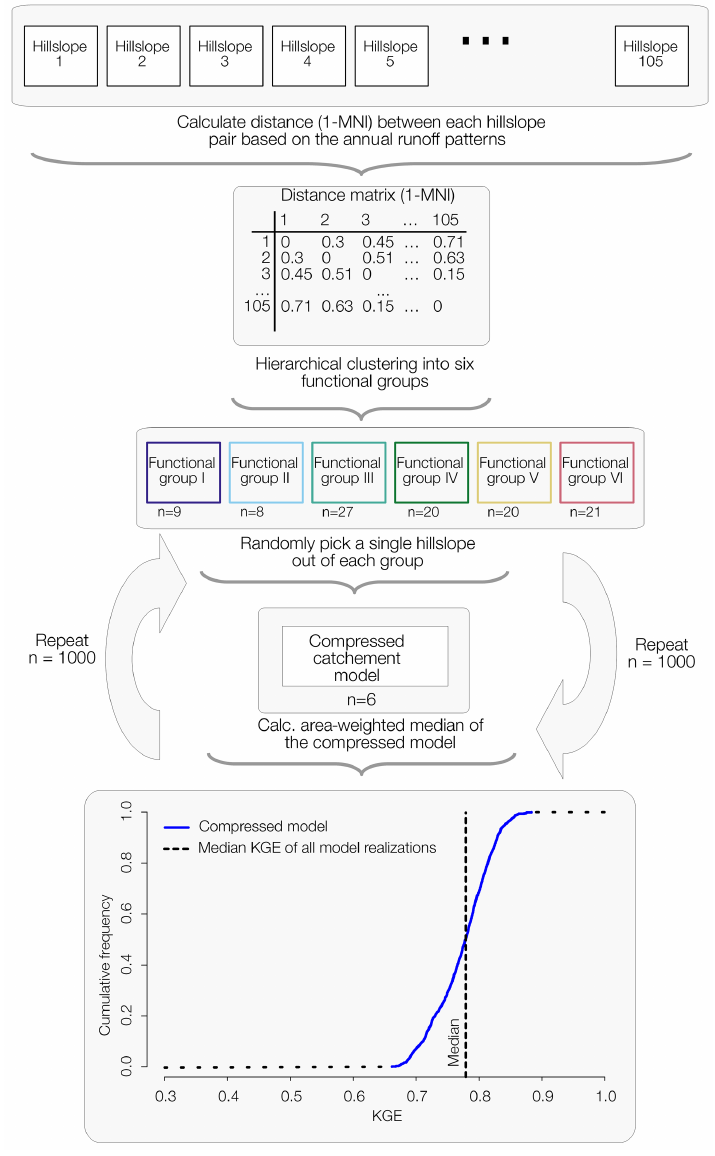
Figure 3. Sketch of the approach for compression and performance evaluation for the compressed catchment